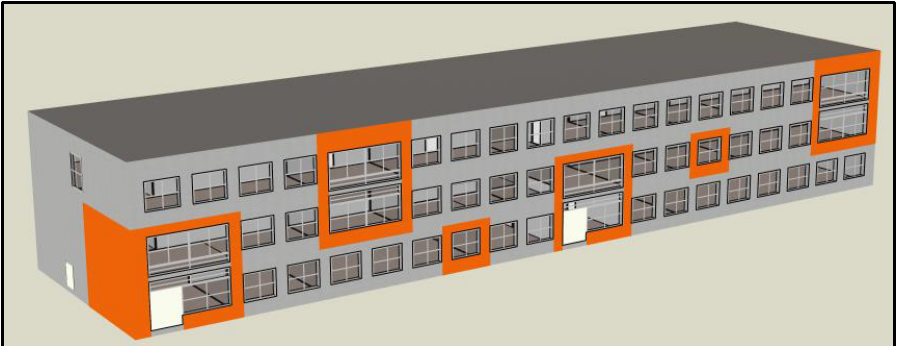
Figure 8. Visualisation of the “A” building (extract from “DesignBuilder”).